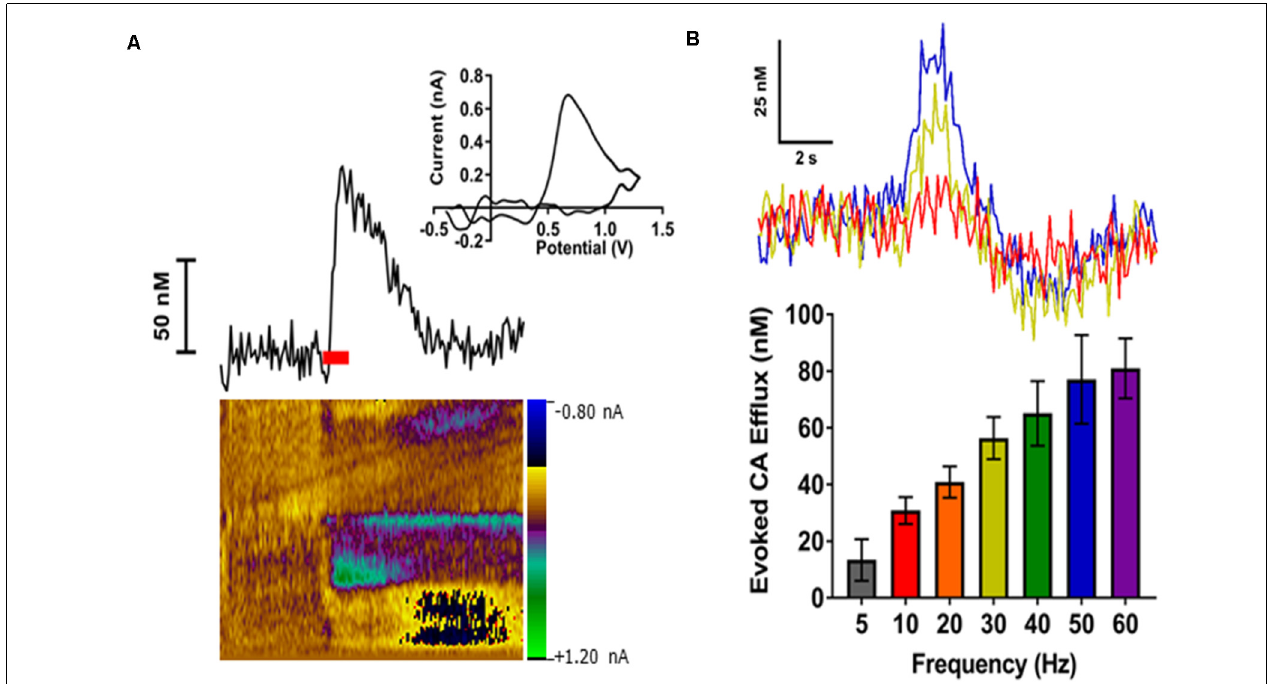
FIGURE 3 | Electrical stimulation of the locus coeruleus (LC) reliably evoked catecholamines (CA) release in the BLA in a frequency-dependent manner. (A) A representative trace showing changes in CA concentration over time (top left). The respective cyclic voltammogram (top right) and color plot (bottom) are also shown. The red bar indicates duration of electrical stimulus. (B) Representative concentration-time traces of CA release (top) in the BLA of an individual rat demonstrate an increased response as stimulation frequency increases (Red = 10 Hz; Yellow = 30 Hz; Blue = 50 Hz). Averaged CA responses (bottom) show higher frequency stimulations resulted in increased efflux concentrations compared to lower frequency stimulations. Data are presented as mean ±